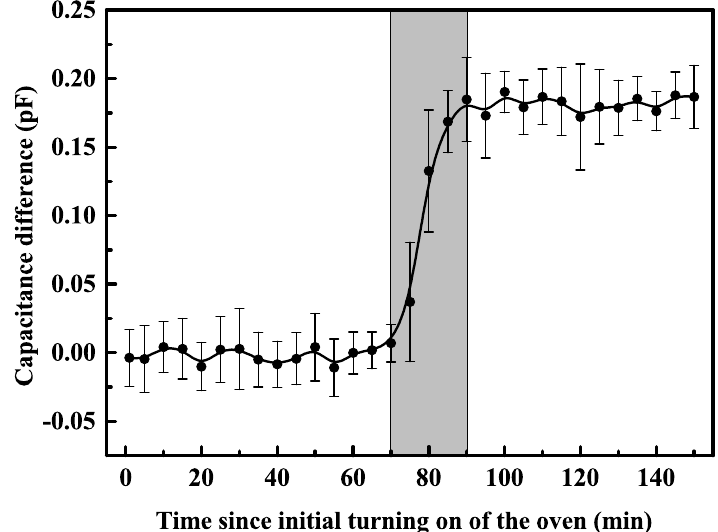
Figure 2. Variation of the capacitance from ten identical trap samples measured over time after turning on the atomic oven, under the Ca vapor pressure 5 × 10 − 4 Pa and temperature 700 K of the atomic oven. The values of the data points are the average of ten trap samples’ capacitances starting when the oven was turned on ( t = 0 min) and continuing after the oven was turned off at t = 5 min. After the oven is turned off, the vacuum returns to 10 − 7 Pa. The maximal capacitance difference is approximately 0.2